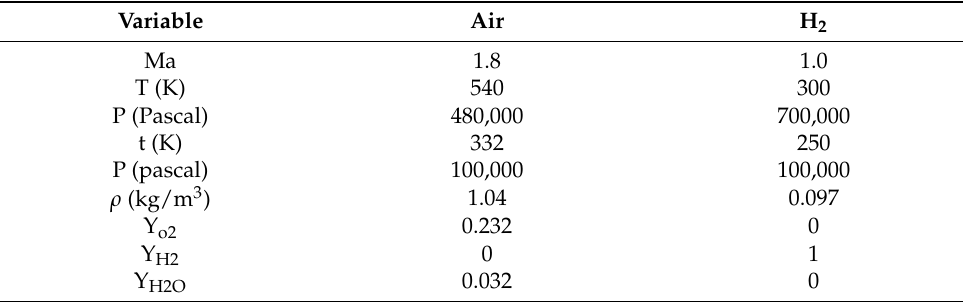
Table 1. The flow conditions of air and hydrogen.